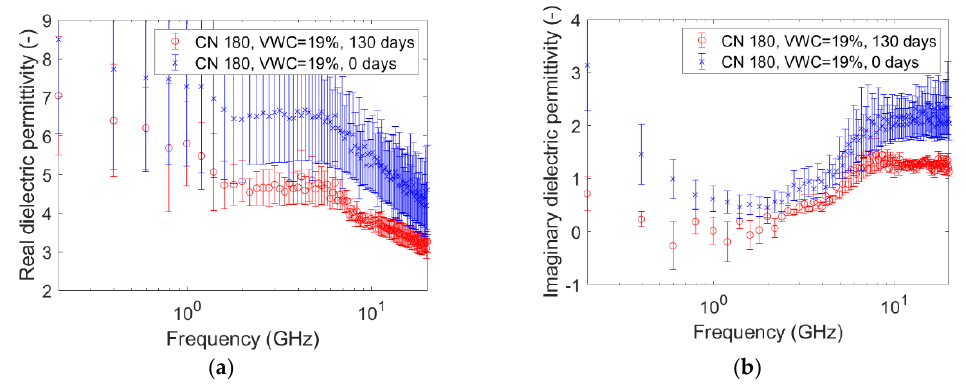
Figure 9. Complex dielectric permittivity before bioremediation and after 130 days: real part ( a ), imaginary part ( b ). Microcosm: C/N = 180. Volumetric water content = 19%.